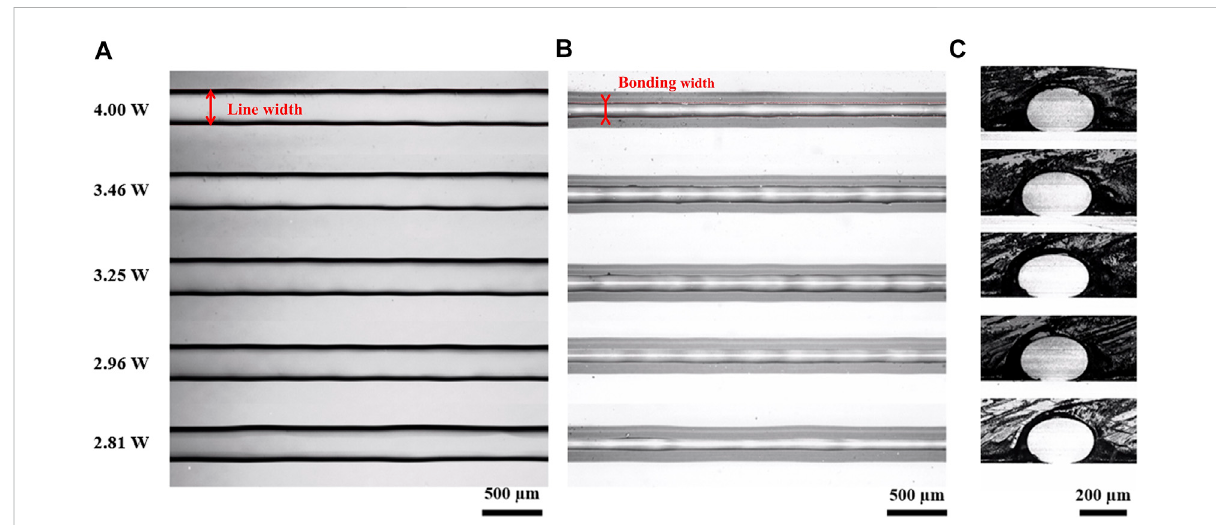
FIGURE 4 Top-view (A) ,bottom-view (B) ,andcross-sectionalimages (C) oflinesprintedat60 mm/min.Thecorrespondinglaserpowerisindicatedin (A) .